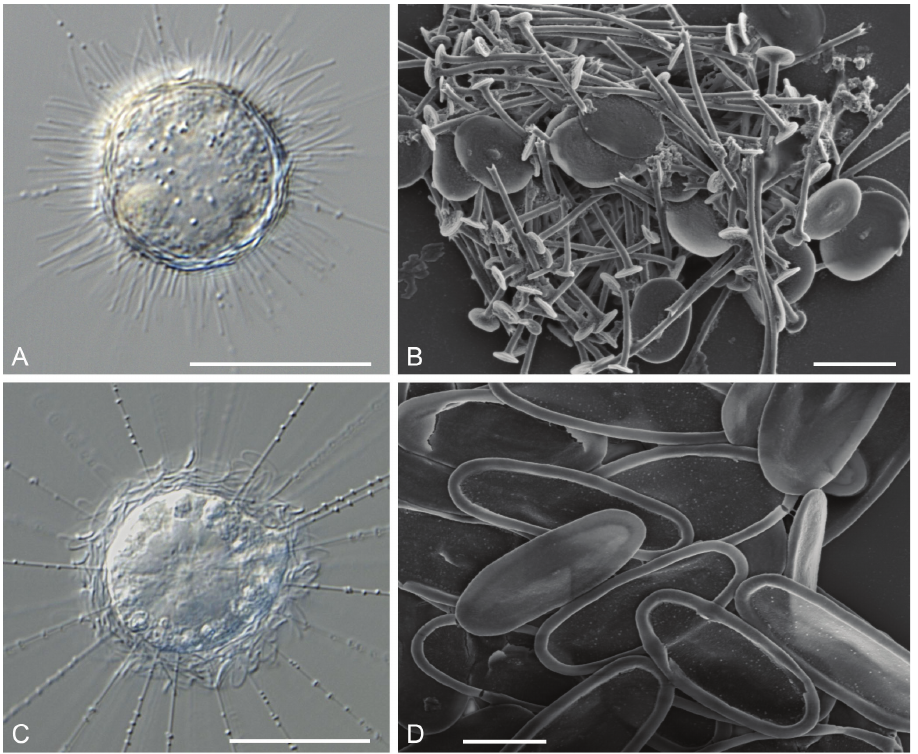
Figure 4. A, B Raphidocystis marginata A LM micrograph of a living cell B REM micrograph of plate-scales and spine-scales C, D Acanthocystis myriospina C LM micrograph of a living cell D REM micrograph of plate-scales. Scale bars: 20 µm ( A, C ); 2 µm ( B, D ); LM, light microscopy; REM, raster electron